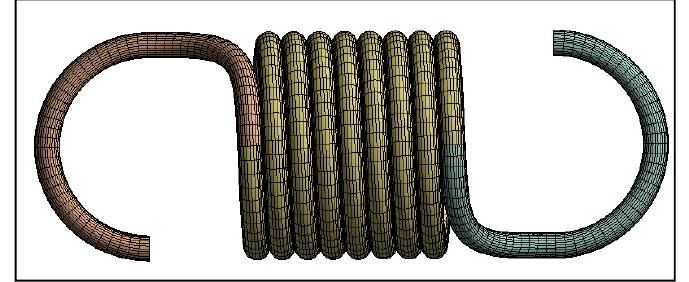
Figure 6. Meshed model.